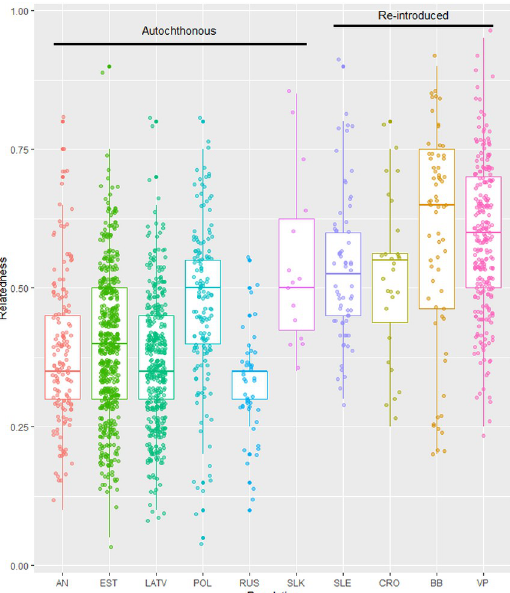
Fig 3. Relatedness ( M xy ) among individuals in Eurasian lynx populations, including northwestern Anatolia and autochthonous and re-introduced lynx populations of central and eastern Europe (based on reanalysis of 10 shared microsatellite loci [14]).